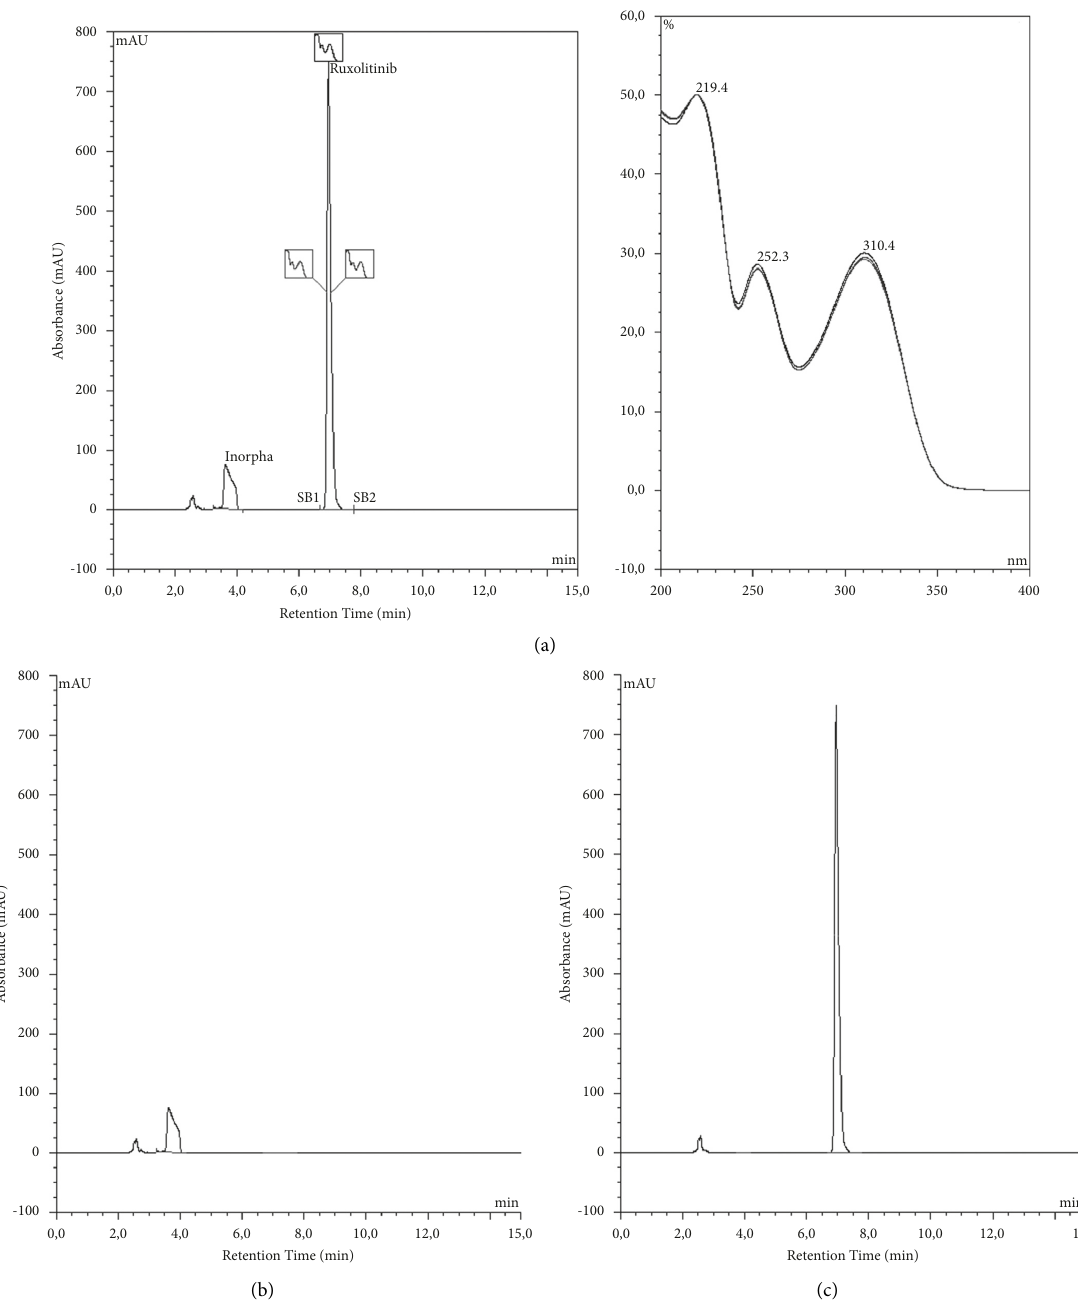
Figure 1: Chromatograms of ruxolitinib in Inorpha ® at 200 μ g/mL (a), blank with just Inorpha (b), and ruxolitinib alone obtained from an analytical standard at 200 μ g/mL